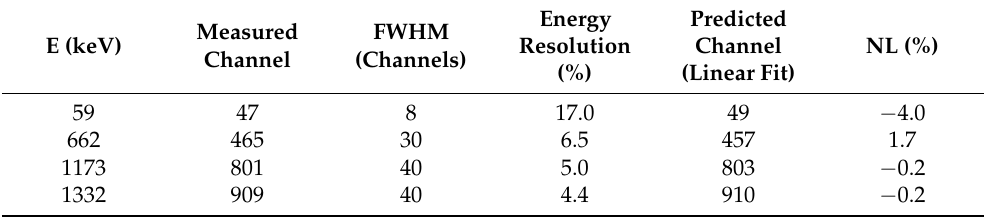
Table 2. Results of the energy